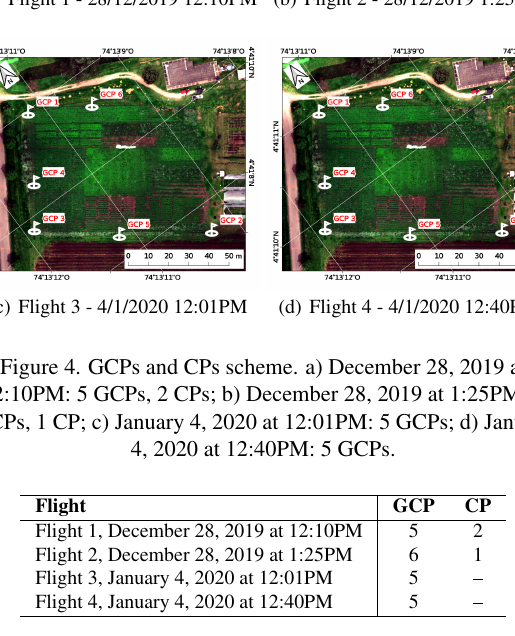
Table 1. Number of GCPs and CPs used for georreferencing.